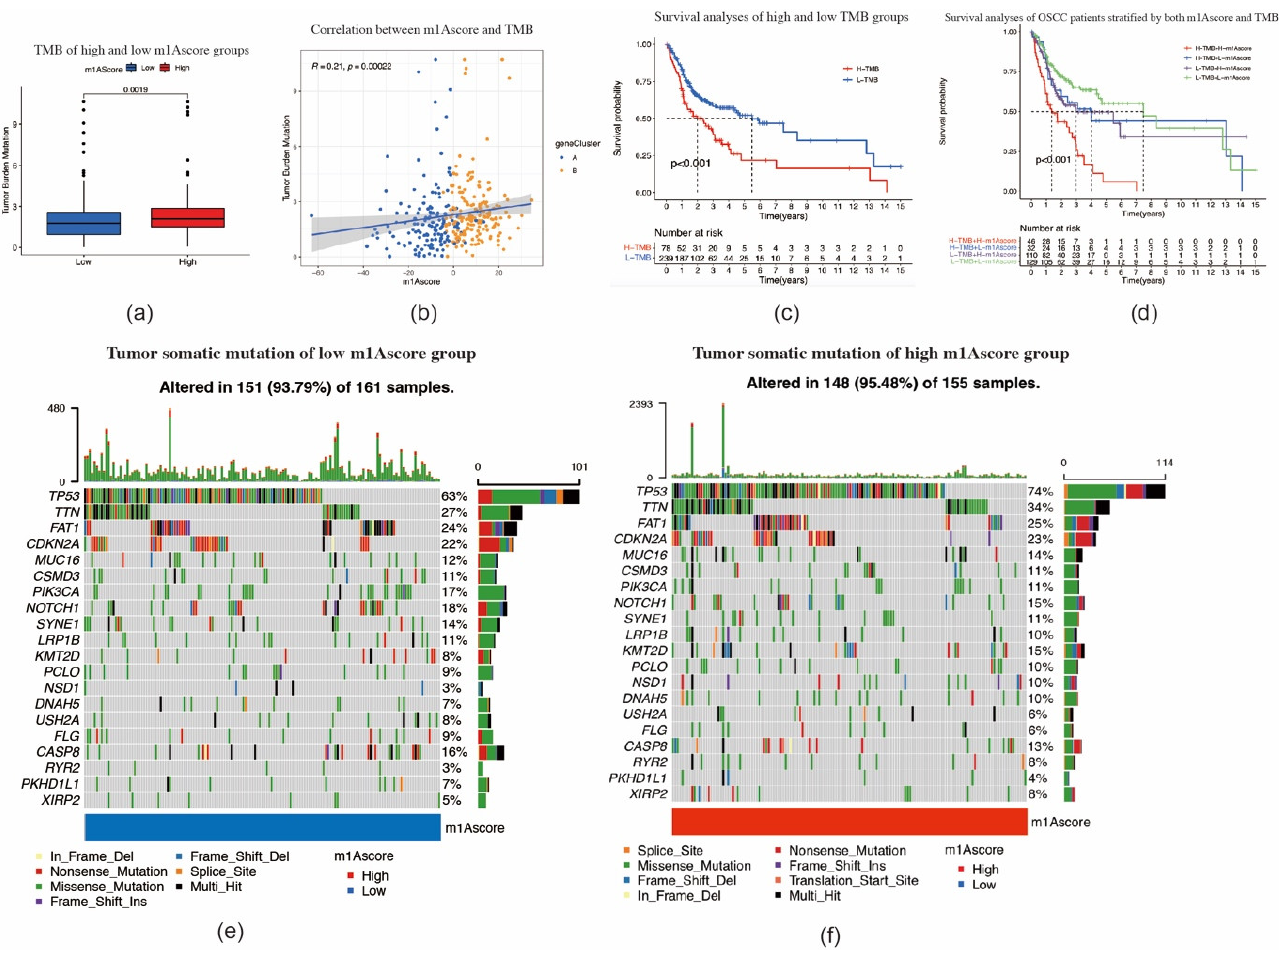
Figure 7. Tumor mutation–related characteristics for m1A scores. ( a ) The high m1A score tumors were markedly